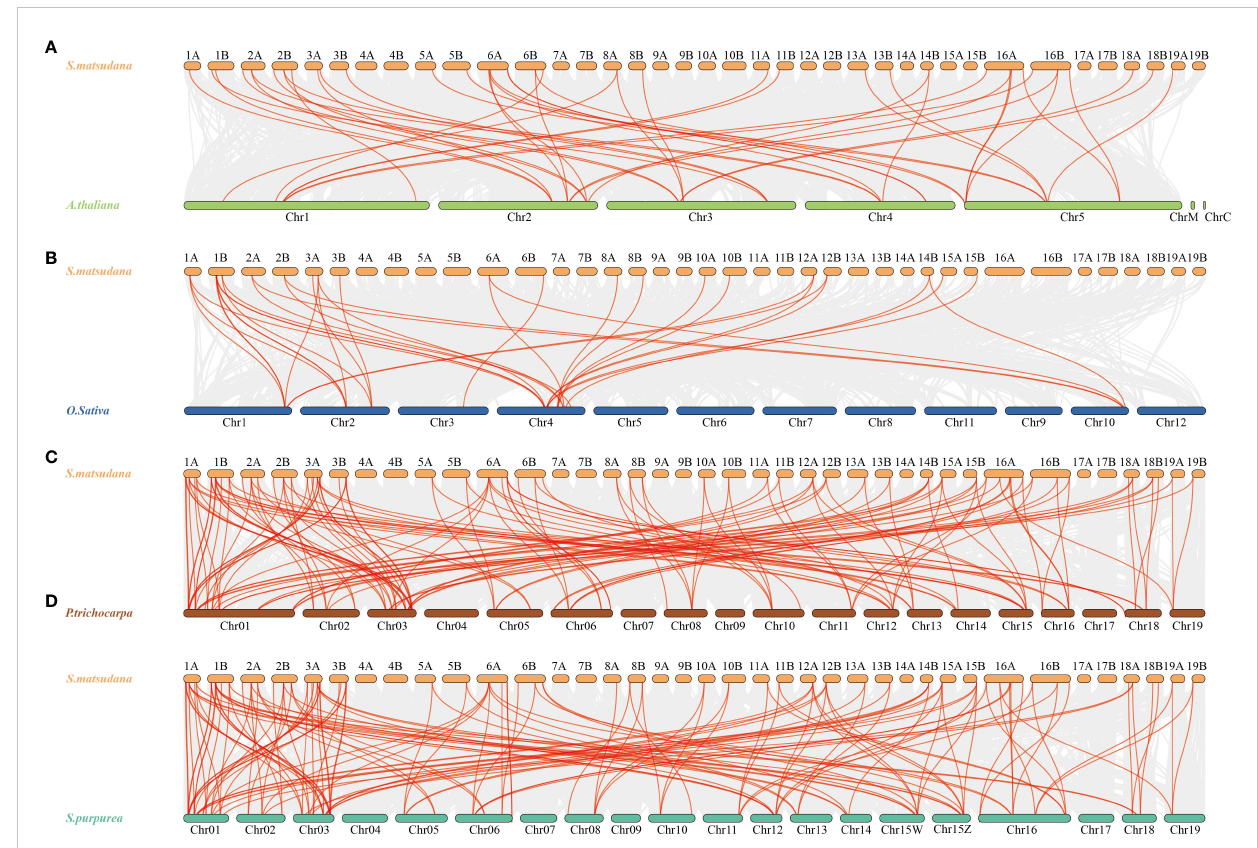
FIGURE 5 Synteny analysis of SmTTF genes between S. matsudana and four related species, A . thaliana , O. sativa , P. trichocarpa and S. purpurea . (A) Synteny analysis of SmTTF genes between S. matsudana and A . thaliana . (B) Synteny analysis of SmTTF genes between S. matsudana and O. sativa . (C) Synteny analysis of SmTTF genes between S. matsudana and P. trichocarpa , (D) Synteny analysis of SmTTF genes between S. matsudana and S. purpurea. Gray lines in the background indicate the collinear blocks within S. matsudana and other plant genomes, whereas red lines highlight syntenic SmTTS gene